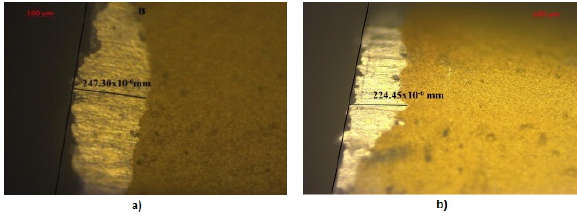
Figure 5: Flank wear of carbide cutting tools a) speed of 605 RPM, feed rate of 0.08 mm/rev and b) speed of 421 RPM, feed rate of 0.12 mm/rev [13]